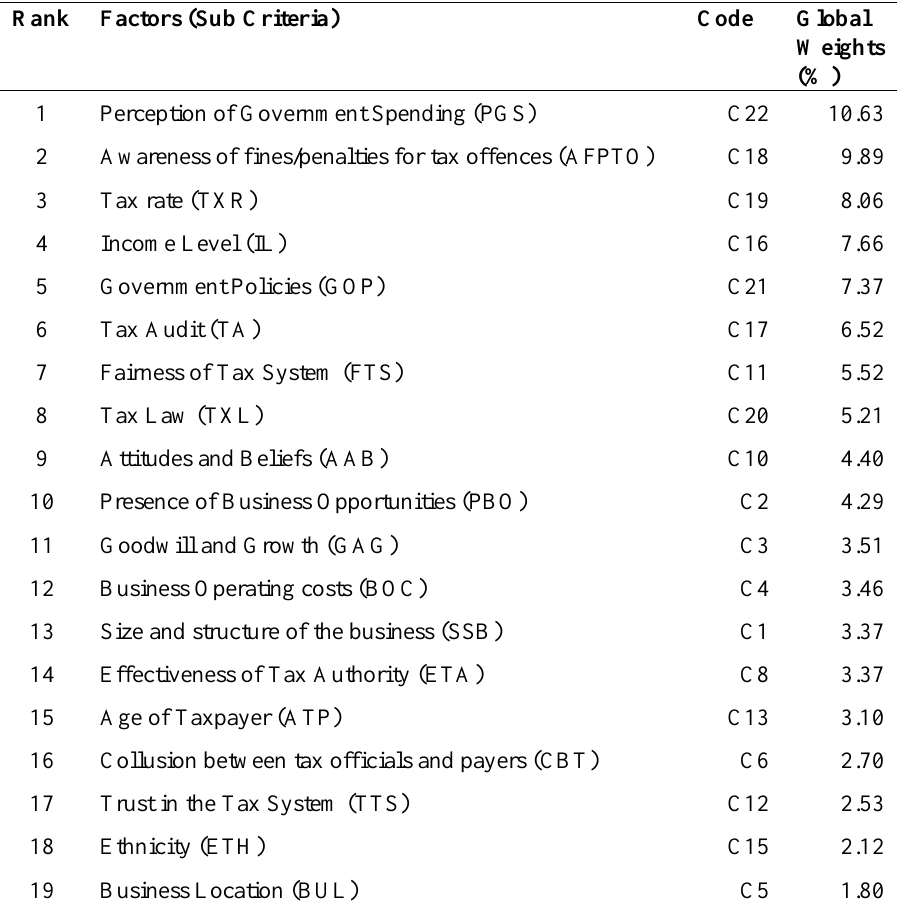
Table 8: Ranking of Sub Criteria